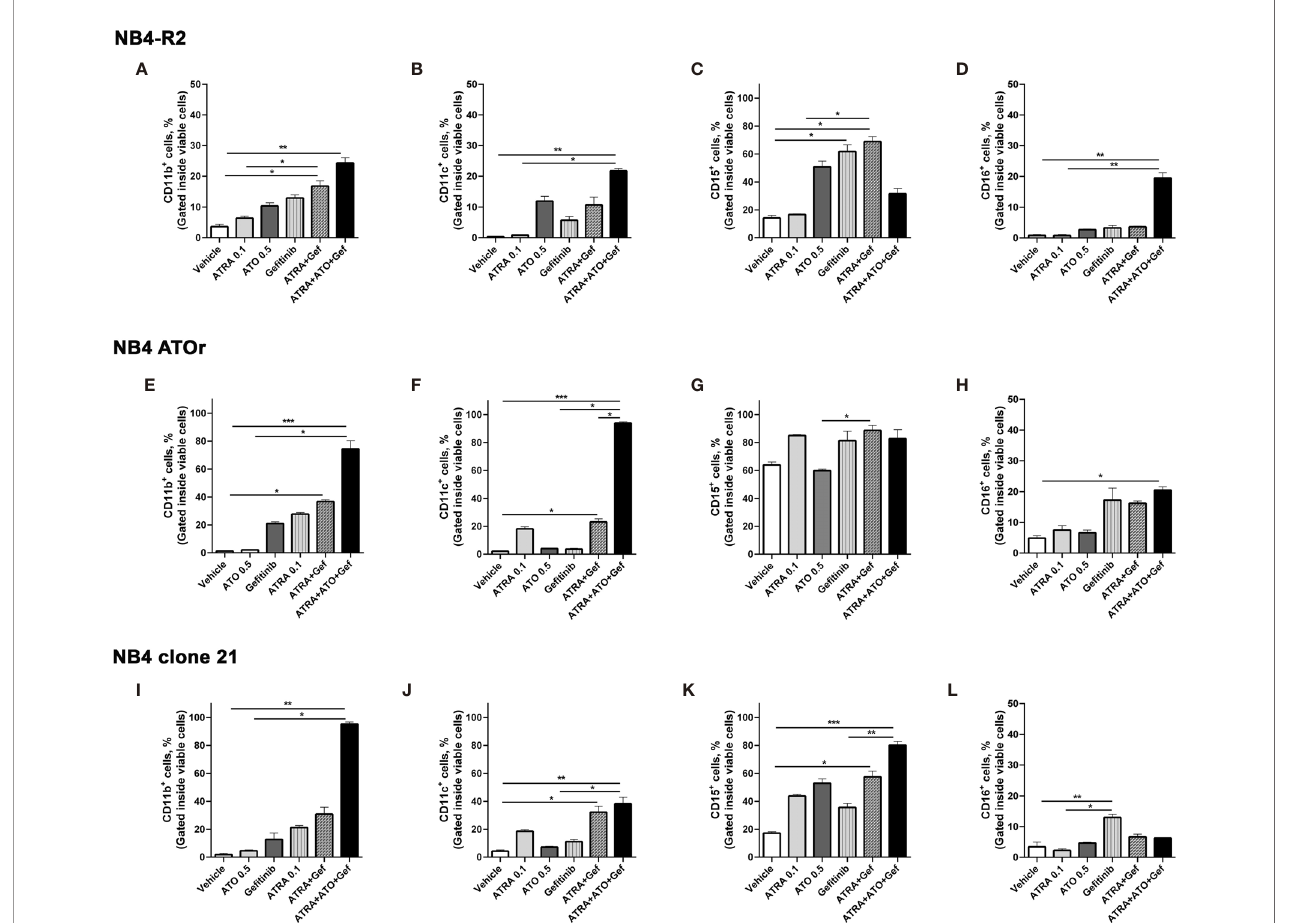
FIGURE 4 | Ge fi tinib therapy sensitizes APL-resistant cells to ATRA and ATO. The APL cell lines NB4-R2 (A – D) , NB4 ATOr (E – H) , and the respective parental NB4 clone 21 (I – L) were treated with ATRA alone (0.1 µM), ATO alone (0.5 µM), ge fi tinib alone (10 µM), ATRA plus ge fi tinib or ATRA and ATO plus ge fi tinib for 72 h and the expression of the myeloid differentiation markers CD11b, CD11c, CD15, and CD16 was measured by fl ow cytometry. Ge fi tinib potentiated the myeloid ATRA- induced differentiation in APL cells resistant to ATRA (NB4-R2) and ATO (NB4 ATOr), as well as in NB4 clone 21 cells. Data represent the mean ± SD of at least three independent experiments. (*) p < 0.05, (**) p < 0.01, (***) p < 0.001 (Kruskal – Wallis test, followed by Dunn ’ s post hoc